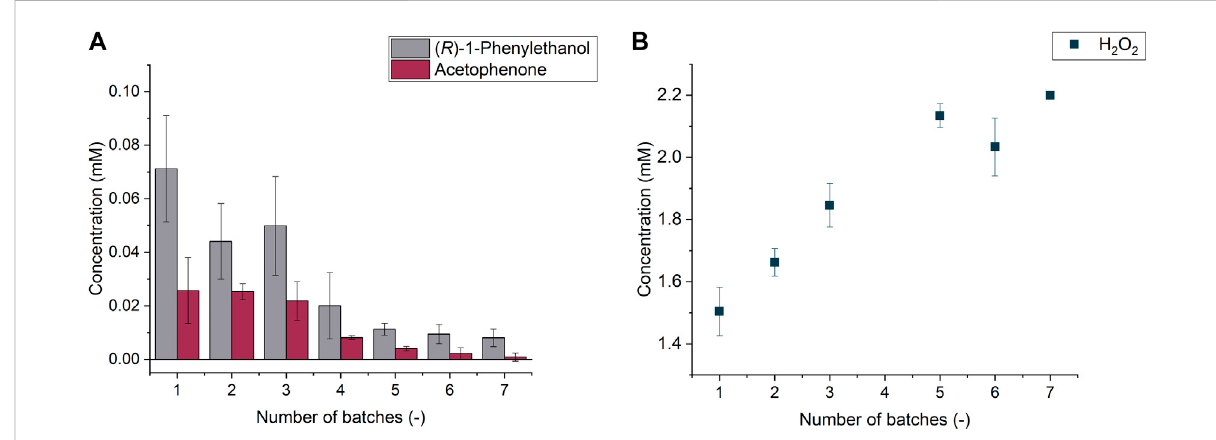
FIGURE 4 ( R )-1-phenylethanol and acetophenone formation through the repeated batches (A) hydrogen peroxide concentration determined at the end of each batch (B)